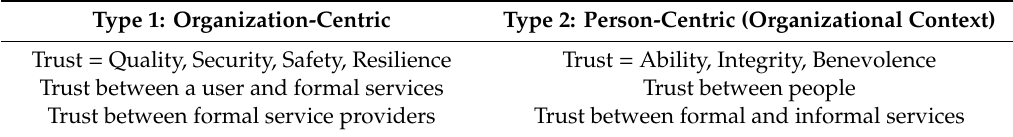
Table 3. Trust model